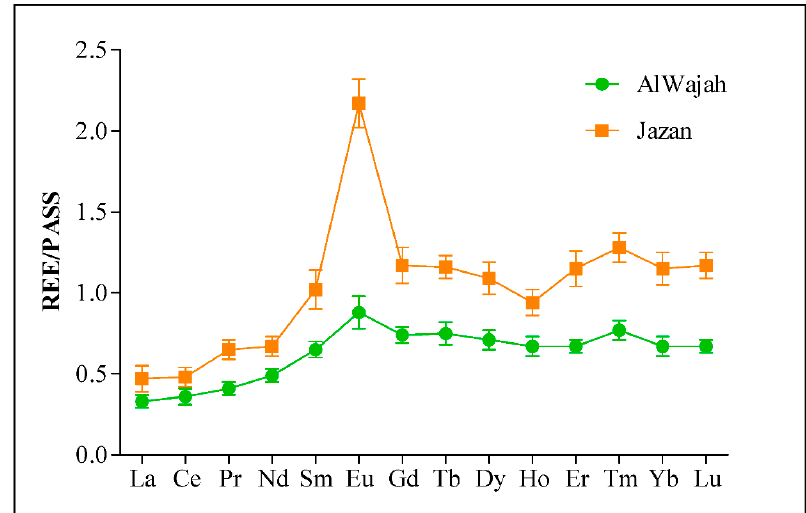
Figure 2. Rare earth elements/Post-Archean Australian Shale (REE/PAAS) patterns for sediments of northern and southern central Red Sea mangrove ecosystems. Values are mean ± standard error. The multi-elemental ratios R(M/L) and R(H/M) indicate positive values correspond-